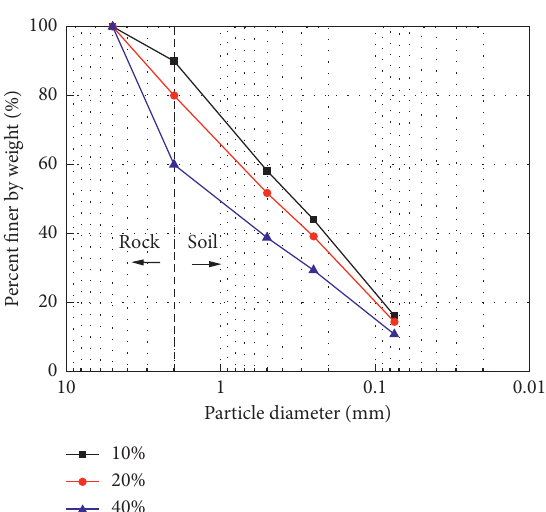
Figure 2: Gradation curves of soil-rock mixture samples with different rock